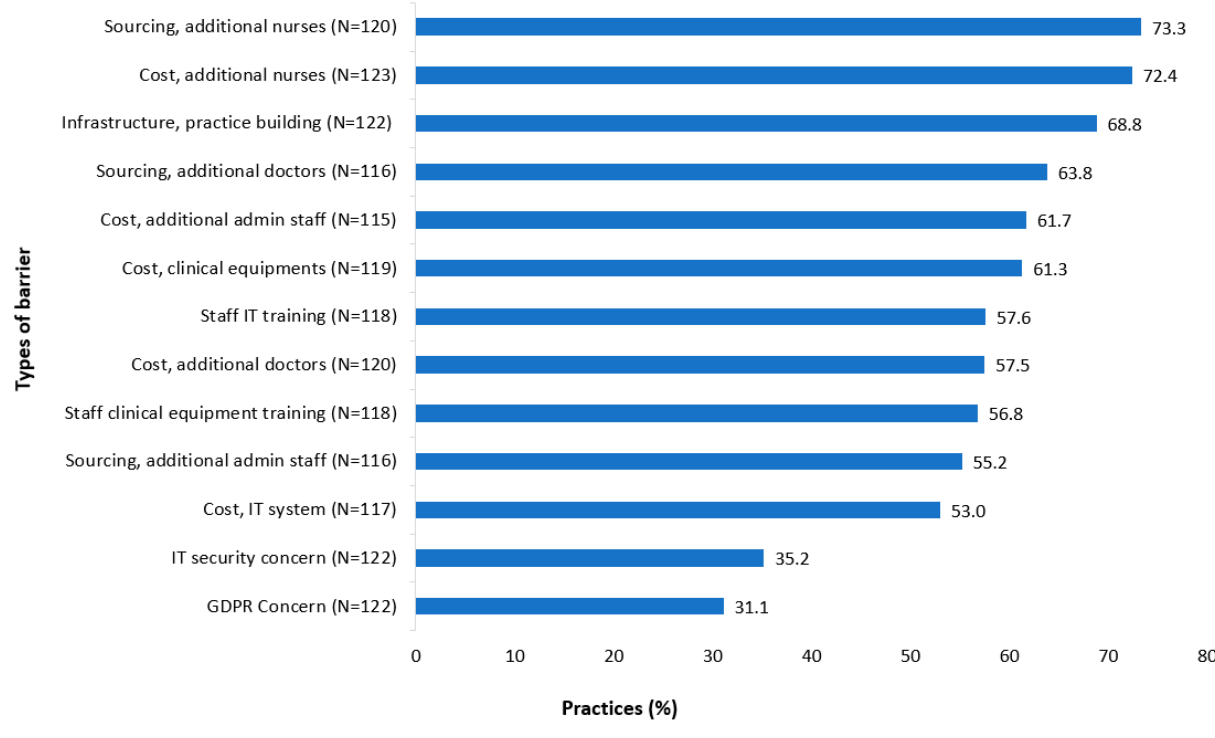
Figure 2. Barriers to implementing HSE CDM programme in general practice.